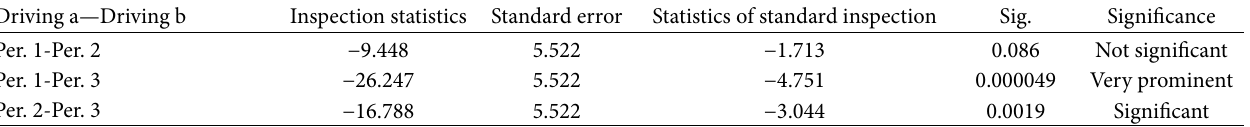
Table 4: Difference of psychological with load subjective evaluation under different driving tasks (day).